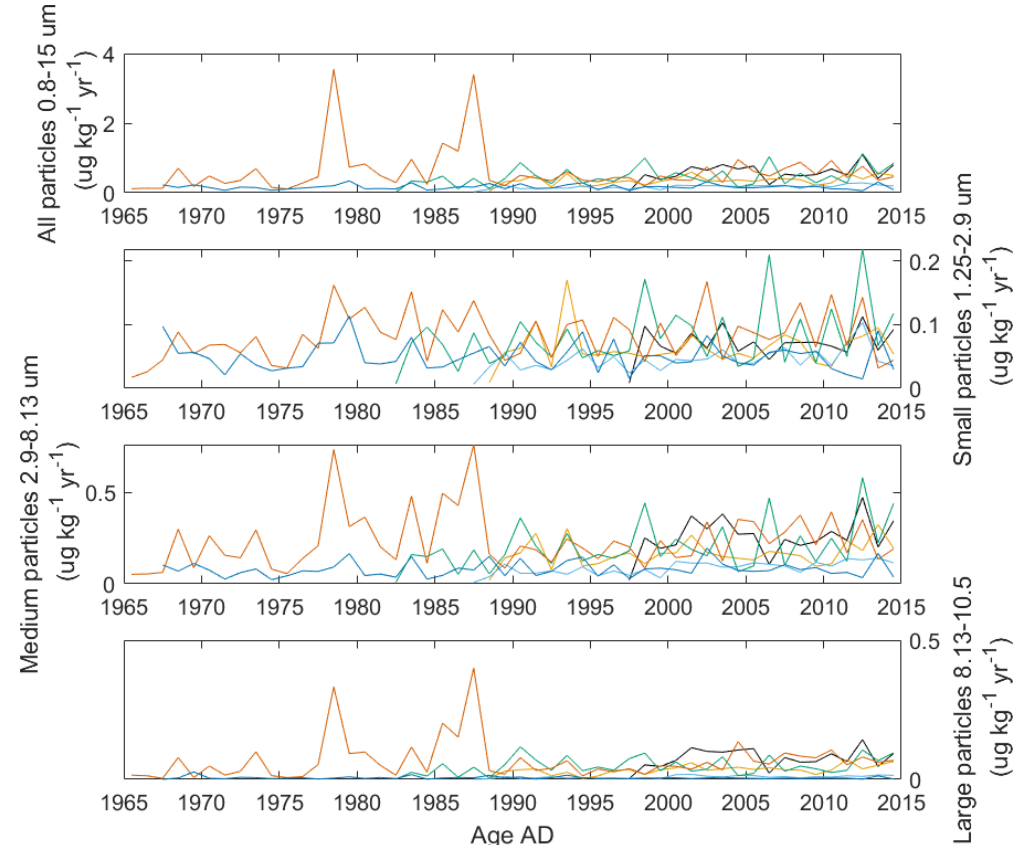
Figure 5. Insoluble dust particle fluxes determined from the Abakus instrument using assumptions of perfect spherical particles and a weight of 2400kgm − 3 . The following datasets are shown (from top to bottom): total particles (0.8–15µm), small particles (1.25–2.9µm), medium particles (2.9–8.13µm) and large particles (8.13–10.5µm). The colors reflect the firn cores T2015-A2 (yellow), T2015-A3 (light blue), T2015-A4 (green), T2015-A5 (orange) and T2015-A6 (dark blue). Table 2. Dust fluxes and trends in dust fluxes for the period 1998–2015 for each of the six shallow firn cores. Small (1.25–2.9µm), inter- mediate (2.9–8.13µm) and large (8.13–10.5µm) refers to the dust sizes as analyzed by the Abakus instrument. The p values are given in parentheses. When these are significant at p < 0 . 2 and p < 0 . 1, they are given in bold and italic, respectively. Firn core Dust flux [µgkgyr − 1 ] Dust flux trend 1998–2015 [µgkgyr − 2 ] ( p value) Total Small